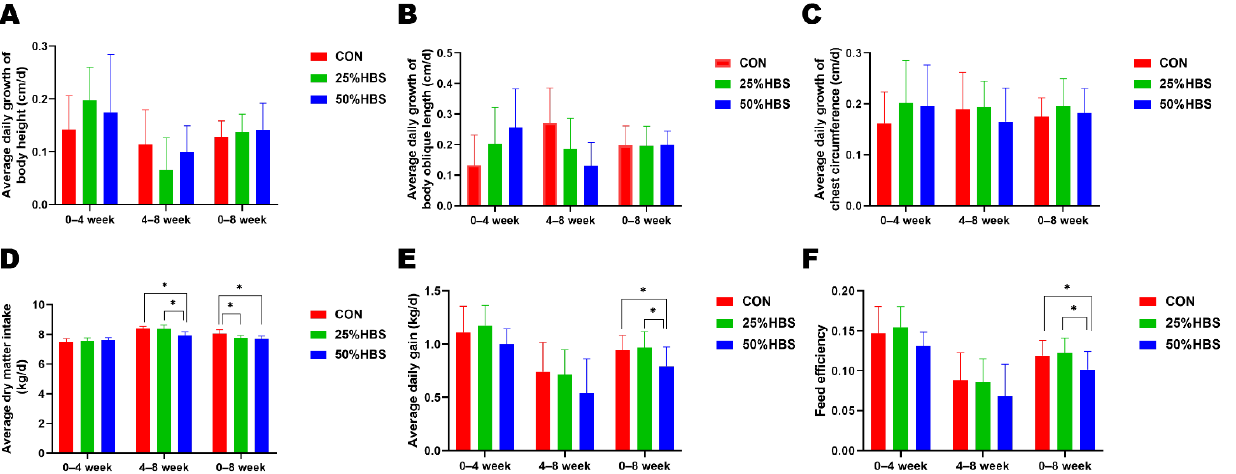
Figure 1. Growth performance of heifers in different treatment groups. ( A ) Average daily growth of body height. ( B ) Average daily growth of body oblique length. ( C ) Average daily growth of chest circumference. ( D ) Average dry matter intake. ( E ) Average daily gains. ( F ) Feed efficiency. Star (*) indicates that there are significant differences between groups.